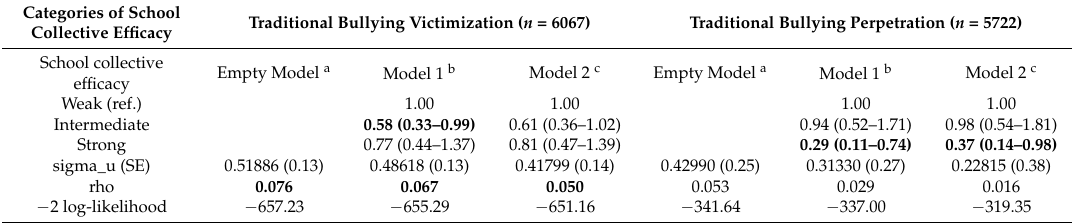
Table 4. Traditional bullying victimization and perpetration regressed on school collective efficacy. Results from two-level binary logistic random intercept models. Odds ratios and 95% (confidence interval (CI))